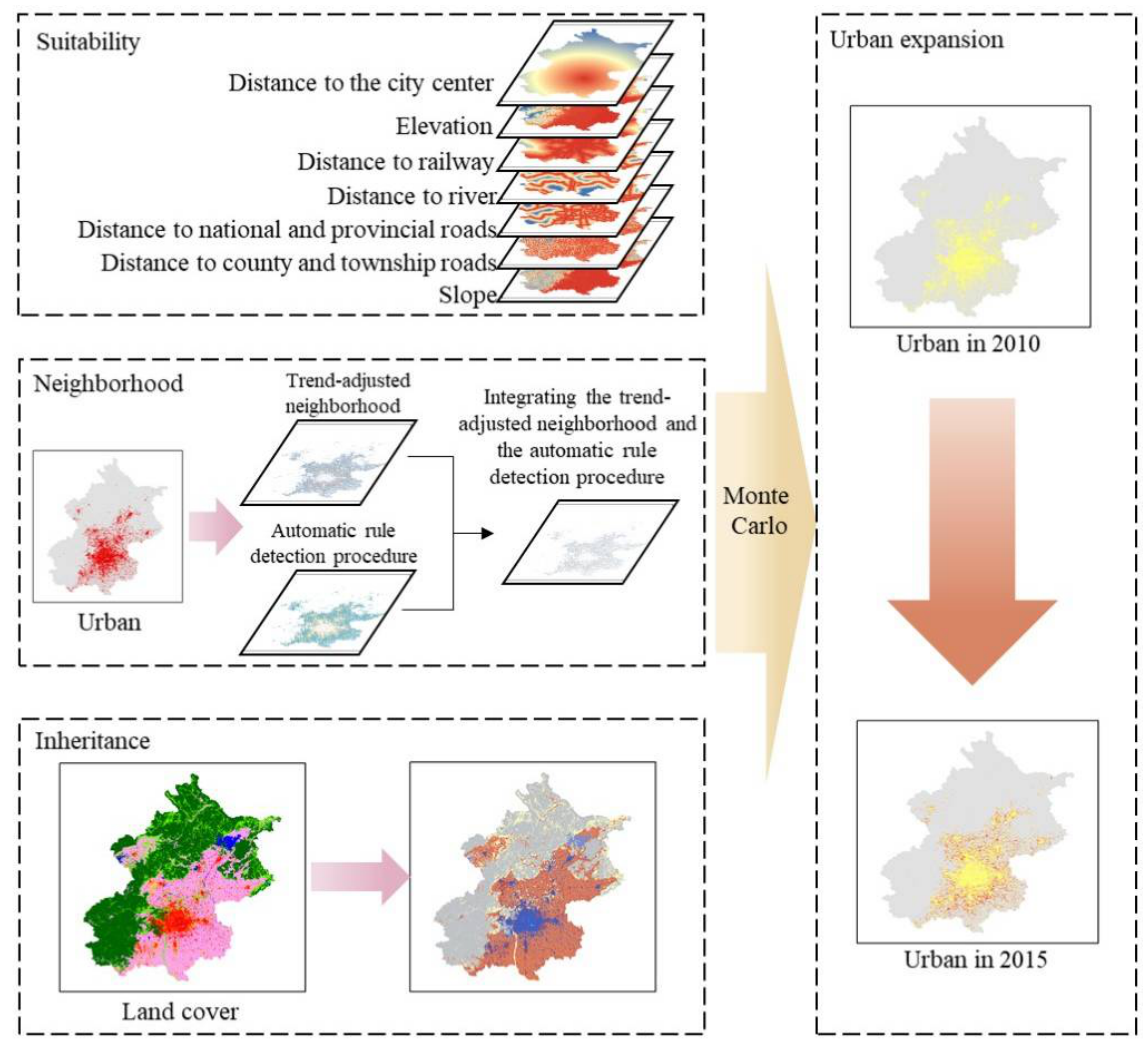
Figure 4. Structure of the improved LUSD-urban model by integrating the trend-adjusted neighborhood and the automatic rule detection procedure.